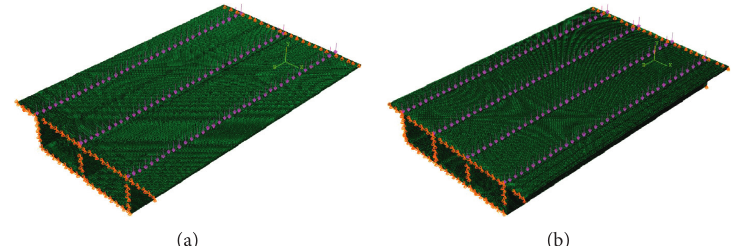
Figure 5: Schemes for the FE models: (a) meshing of the model of 1B2C; (b) meshing of the model of 1B3C.